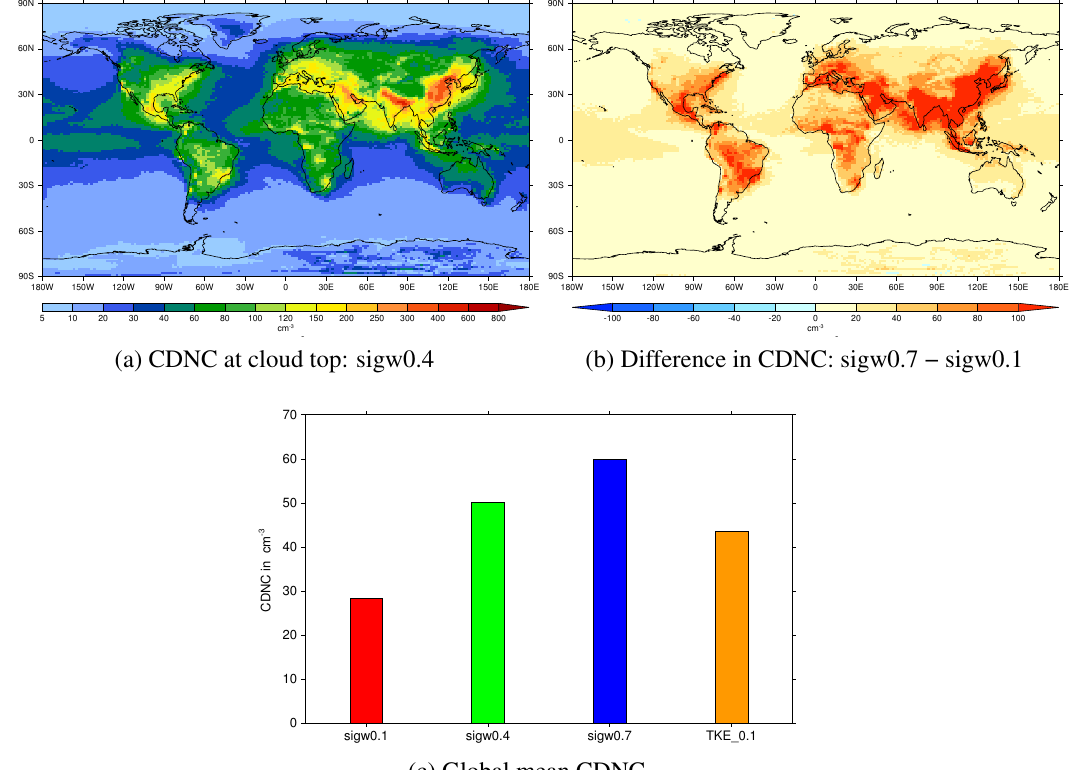
Figure 2. (a) Annual mean cloud droplet number concentration at cloud top in model configuration sigw0.4 (area-weighted mean, AWM=50.17 cm − 3 ), (b) difference in annual mean CDNC at cloud top between model runs sigw0.7 and sigw0.1 (AWM = 31.50cm − 3 ) and (c) global mean CDNC at cloud top for each model configuration. Note non-linear colour bar in (a) . makes significant departures from the reference case ( σ w = 49 0 . 4ms − 1 ) in both positive and negative